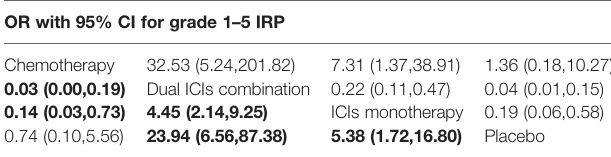
TABLE 2 | Multiple treatment comparison for IRP based on network consistency model (for grade 1 – 5 IRP). OR with 95% CI for grade 1 – 5 IRP